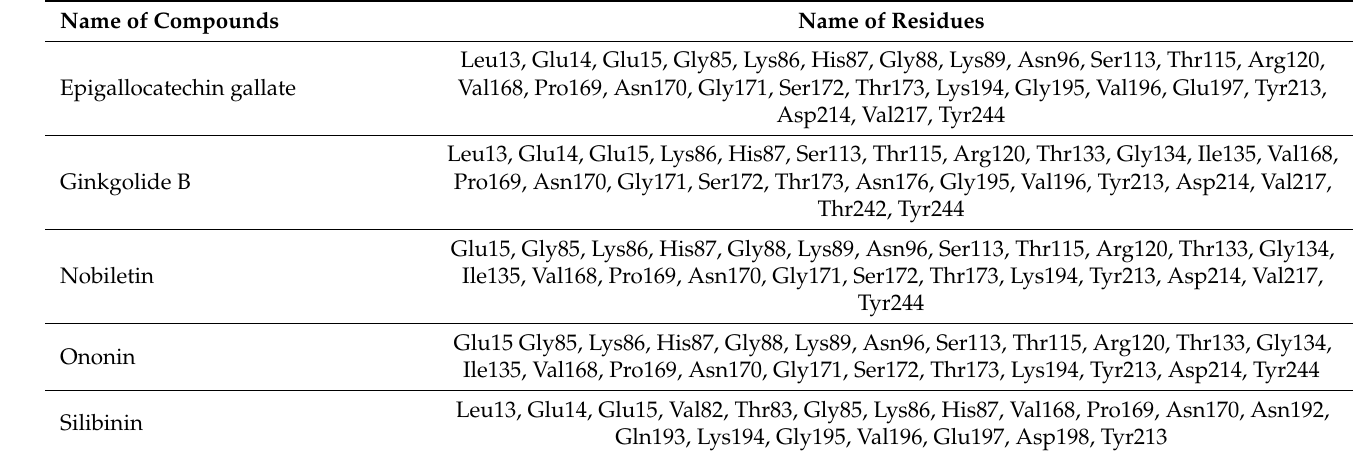
Table 3. Amino acid residues are involved in hydrogen bonding and hydrophobic interactions, and subsequent change in the solvent-accessible area after rigid